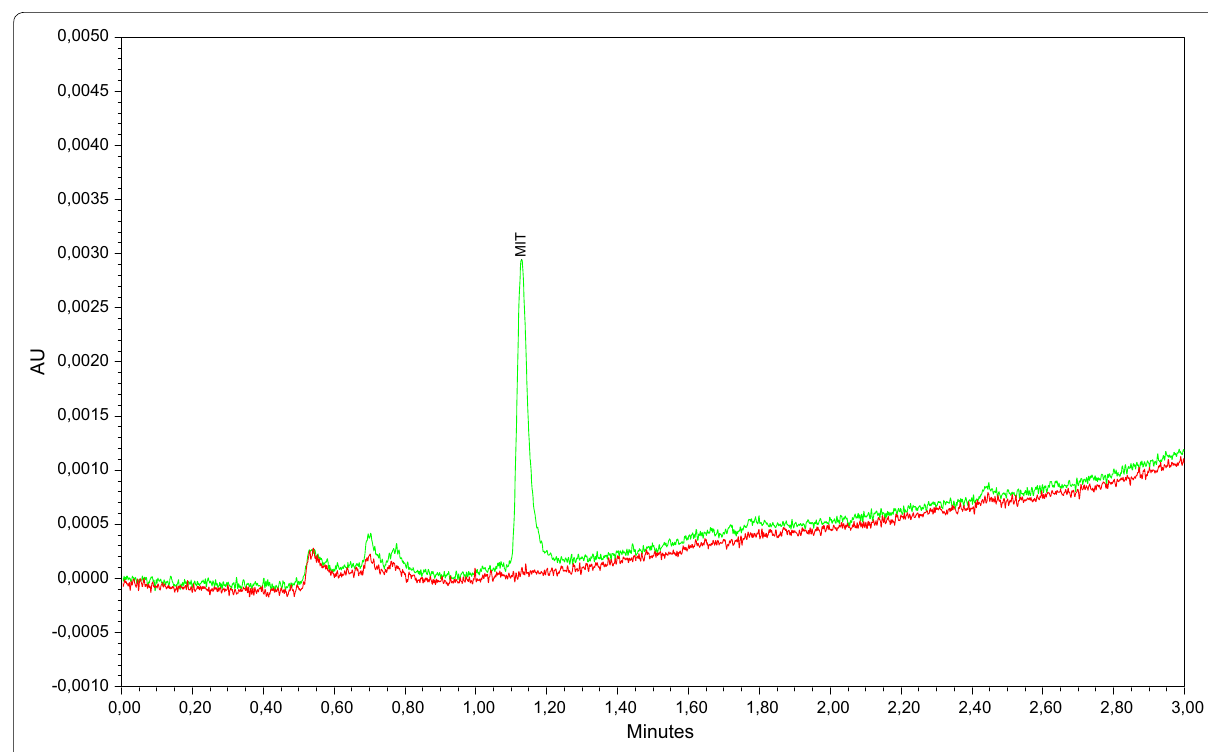
Table 1 MI-residue analysis of laundry fabrics after washing Products measured PES washed Co/PES